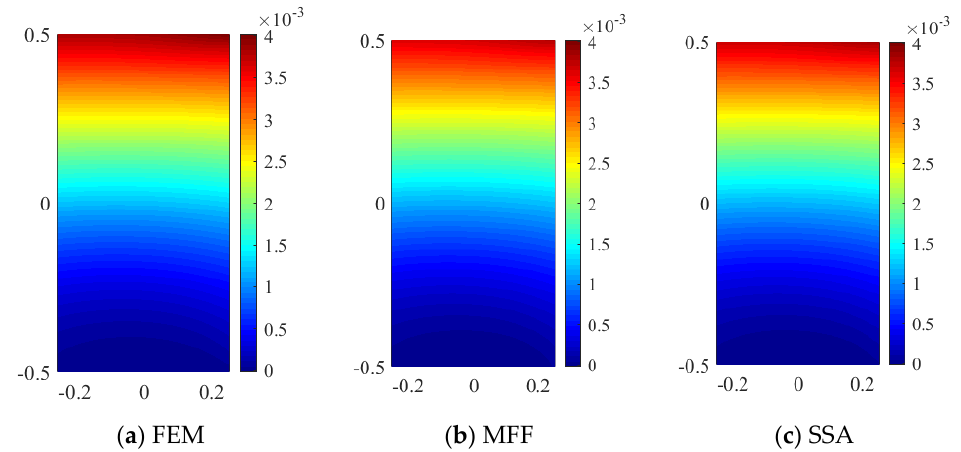
Figure 11. Displacements of u 1 calculated by the FEM and improved RBFCM.